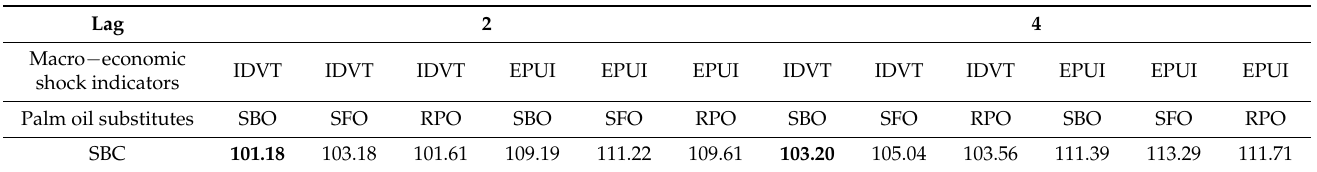
Table 3. Comparison of the AIC and SBC values of each of the six models investigated for two − lag and four − lag specifications.